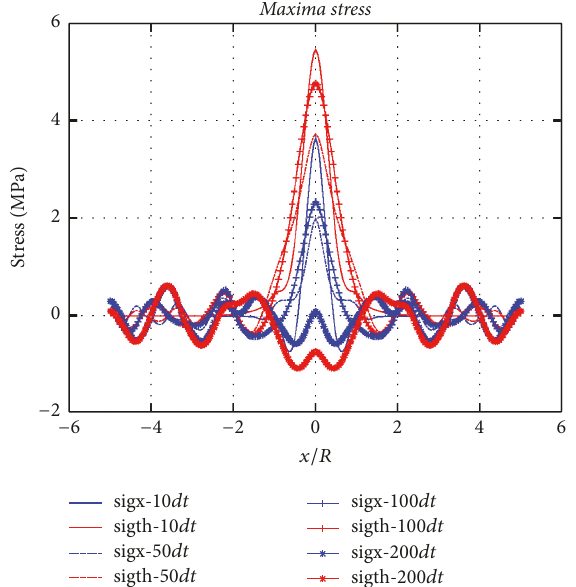
Figure 3: Maximum axial stress (blue) and hoop stress (red) at varied times (dt = 0.2 msec, corresponding to 2msec, 10msec, 20 msec, and 40 msec).